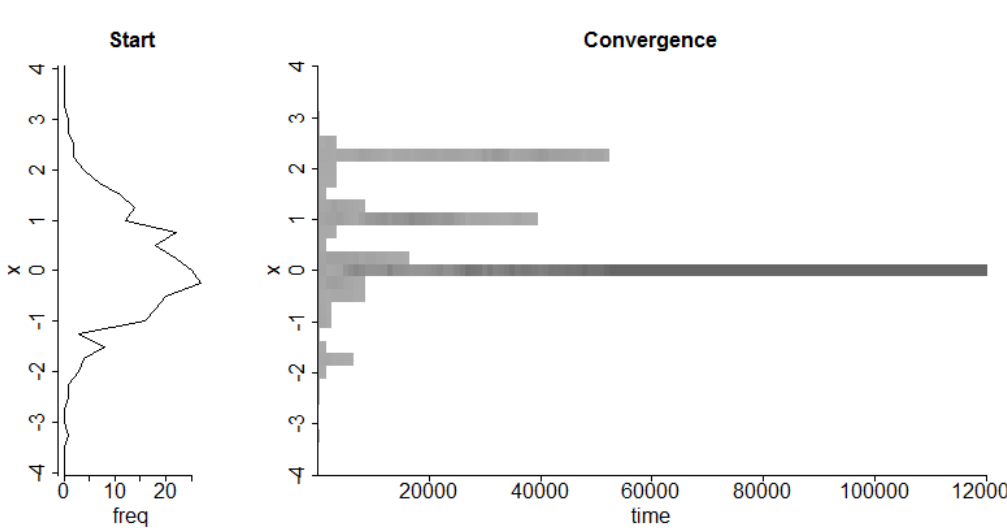
Figure 5: Starting distribution and convergence of a typical run Figure 6: Convergence points with different correlations between attribute and degree